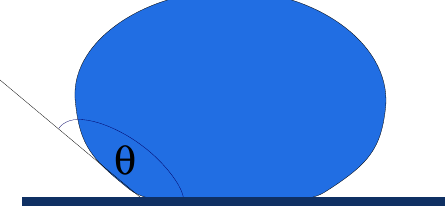
θ Слика 3 - Контактни угао између површине течности и површине чврсте подлоге када течност „ не кваси ” површину Figure 3 - The contact angle between the liquid surface and the surface of a solid substrate when the liquid "does not wet" the surface Рис . 3 – Угол между поверхностью жидкости и несмачиваемой поверхностью